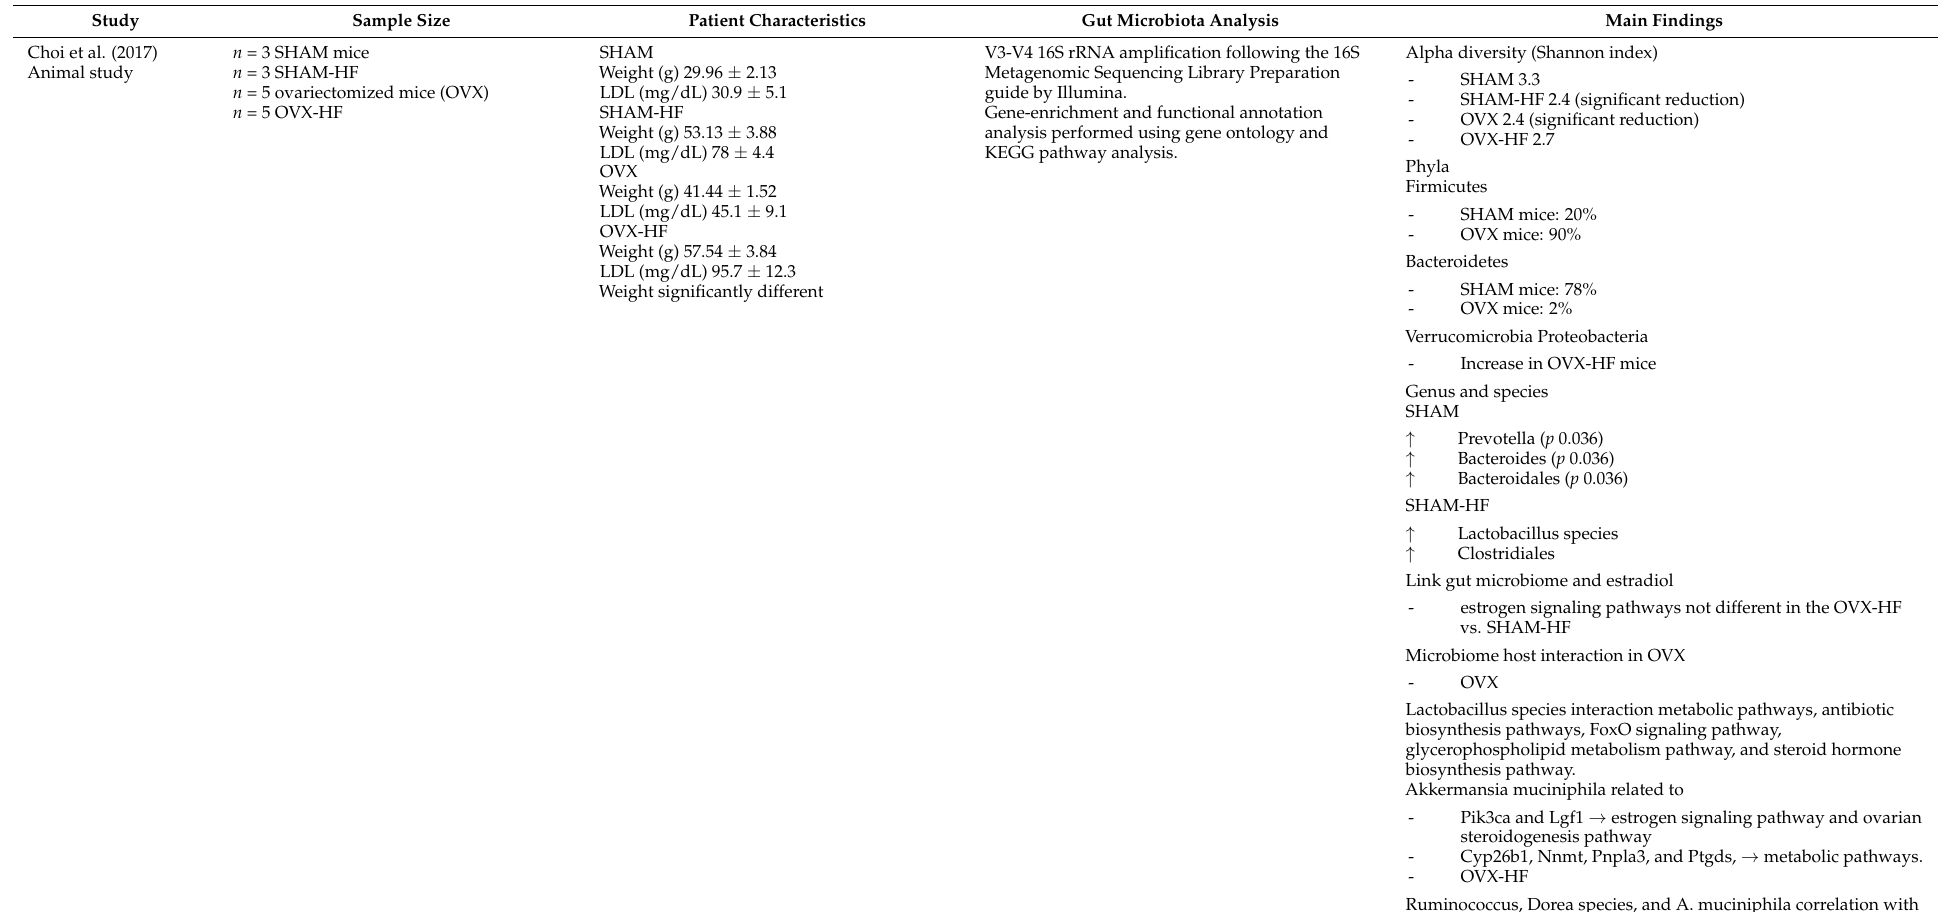
(a) Obesity in Women and Gut Microbiome